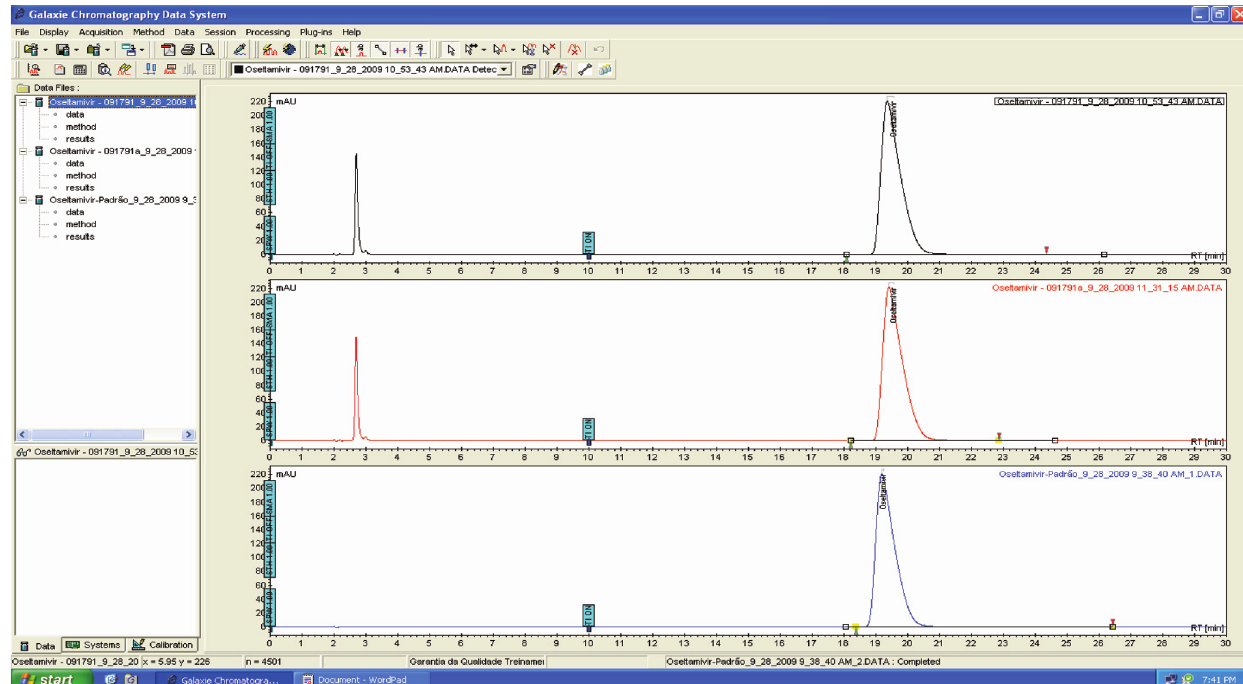
Figure 2 - HPLC confirmation of the active ingredient (Oseltamivir phosphate).